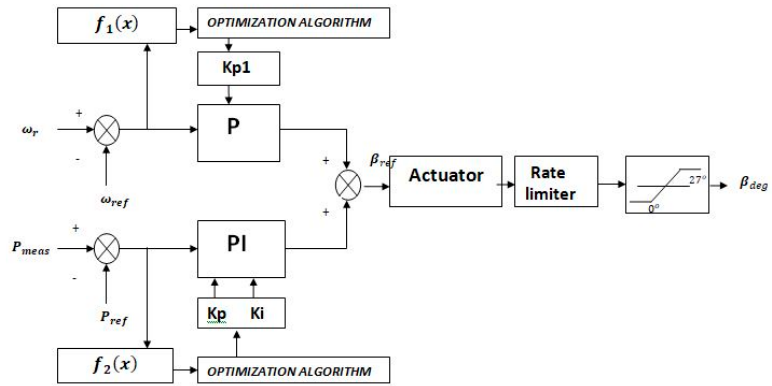
Figure 5. Optimized pitch angle control model for DFIG − based WTS.